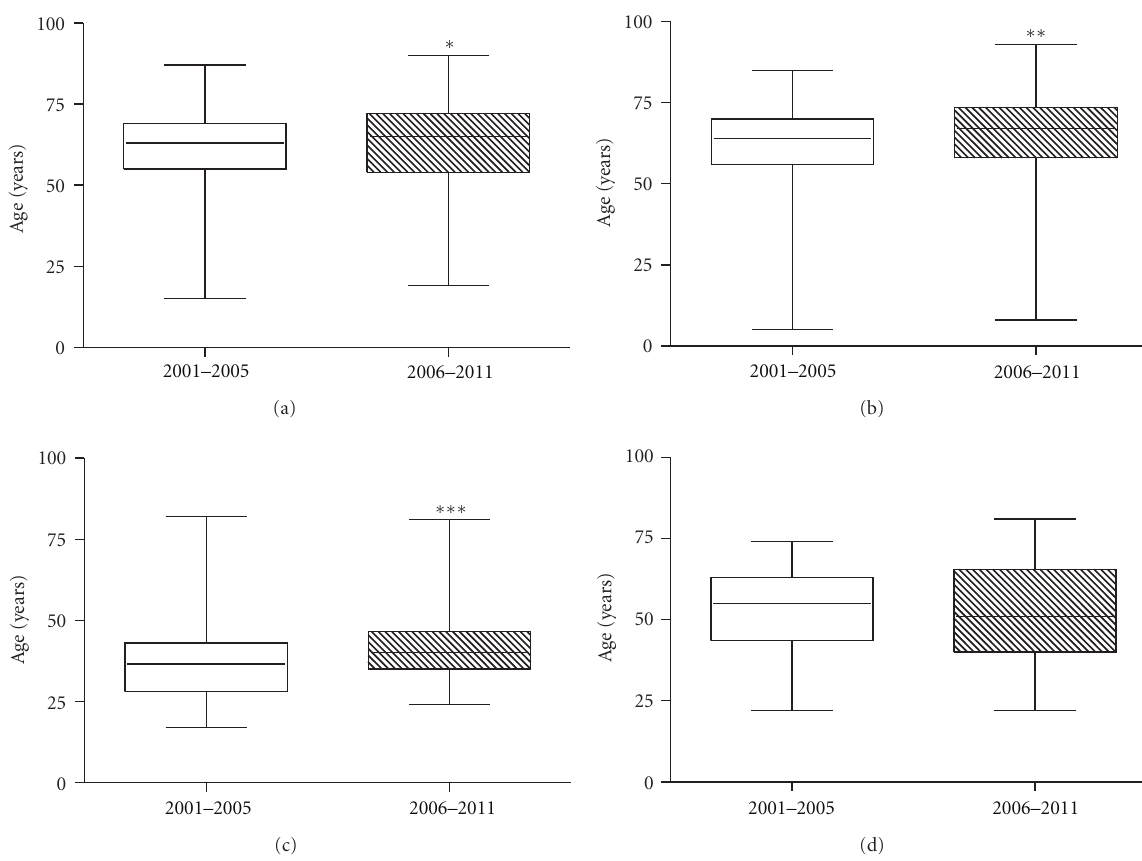
Figure 2: Box plot of HCV genotype 1b (a), genotype 2a/2c (b), genotype 3 (c) and genotype 4 (d) distribution by patient age in the 2001– 2005 and 2006–2011 periods of time. ∗ P = 0 . 0035 versus 2001–2005 by Mann-Whitney test. ∗∗ P = 0 . 0083 versus 2001–2005 by Mann- Whitney test. ∗∗∗ P = 0 . 0009 versus 2001–2005 by Mann-Whitney test.